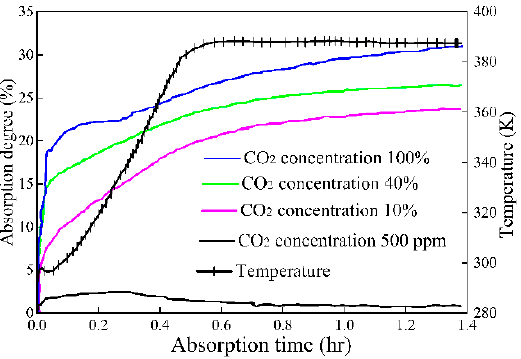
Figure 6. Dependence of CO 2 concentrations on the absorption degree of LiTiO 2 . Table 5. Dependence of the concentrations of CO 2 in the atmosphere on the degree of absorption .